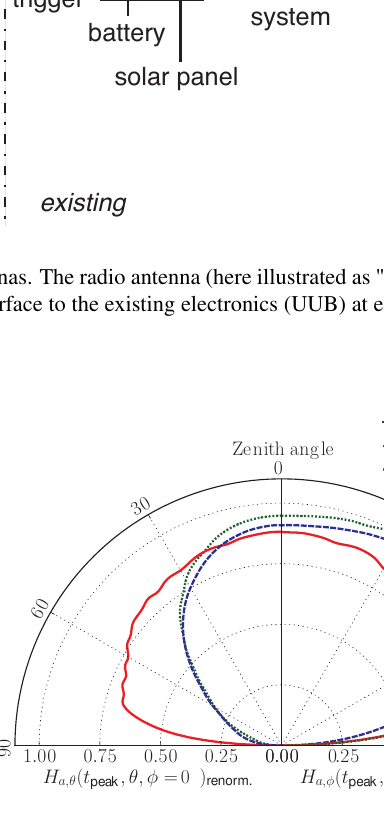
Figure 10. Peak directional diagram for the SALLA antenna together with the two antenna types installed at AERA, the loga- rithmic periodic dipole antenna (Small Black Spider) and the but- Figure 13: The PI installing terfly antenna: the development of the maximum absolute value hardware for AERA in the field. of the vector e ff ective length (VEL) in the time domain is dis- played as a function of zenith angle. The two components of the VEL are treated separately. The zenith angle dependence of the (cid:126) e θ -component of the VEL is shown in the left half of the diagram. In the right half the (cid:126) e φ -component is depicted. Two azimuthal directions have been chosen to maximize the readings of the respective VEL component. For details, see